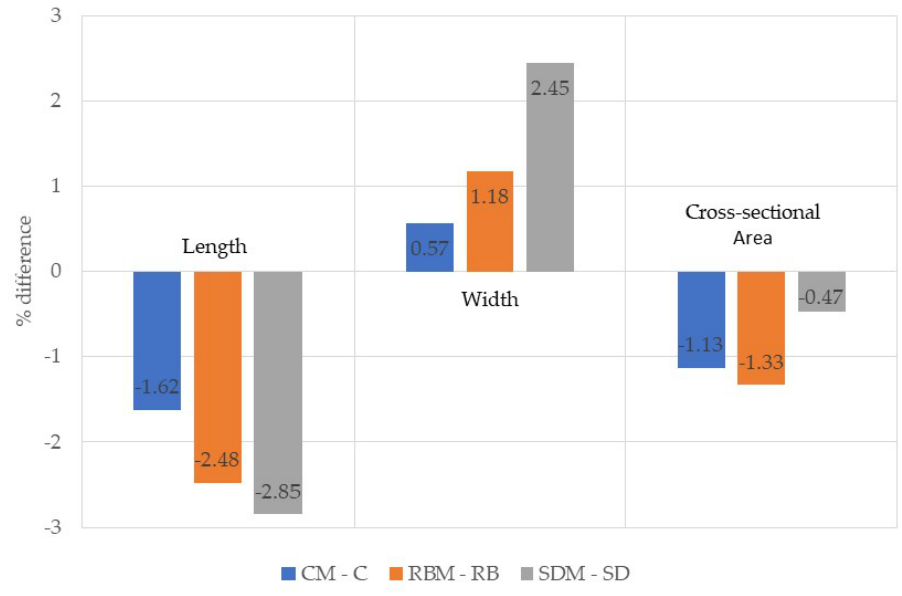
Figure 11. Percentage difference on length, width, and cross-sectional area from non-mycelium bricks.